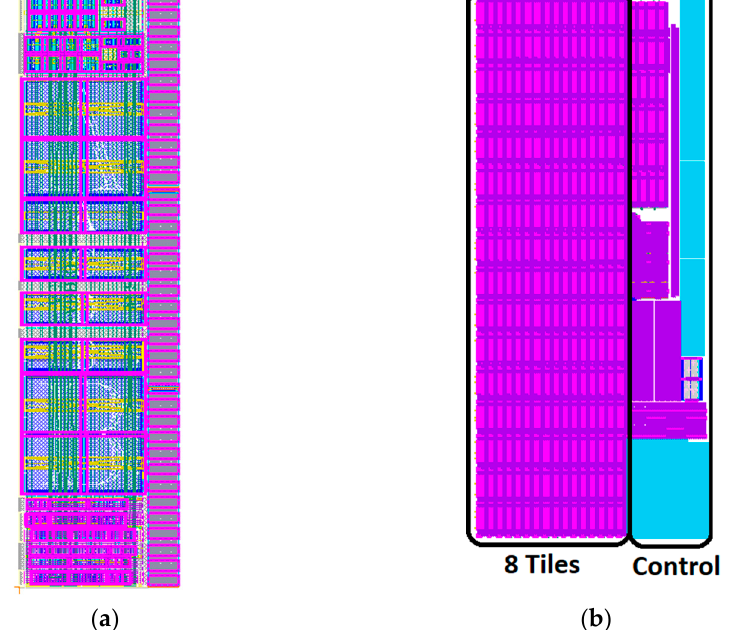
Figure 14. The layout of: ( a ) the charge pump unit; ( b ) the complete system floorplan.